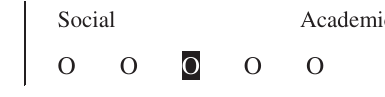
FIG. 1. Cover page of the network